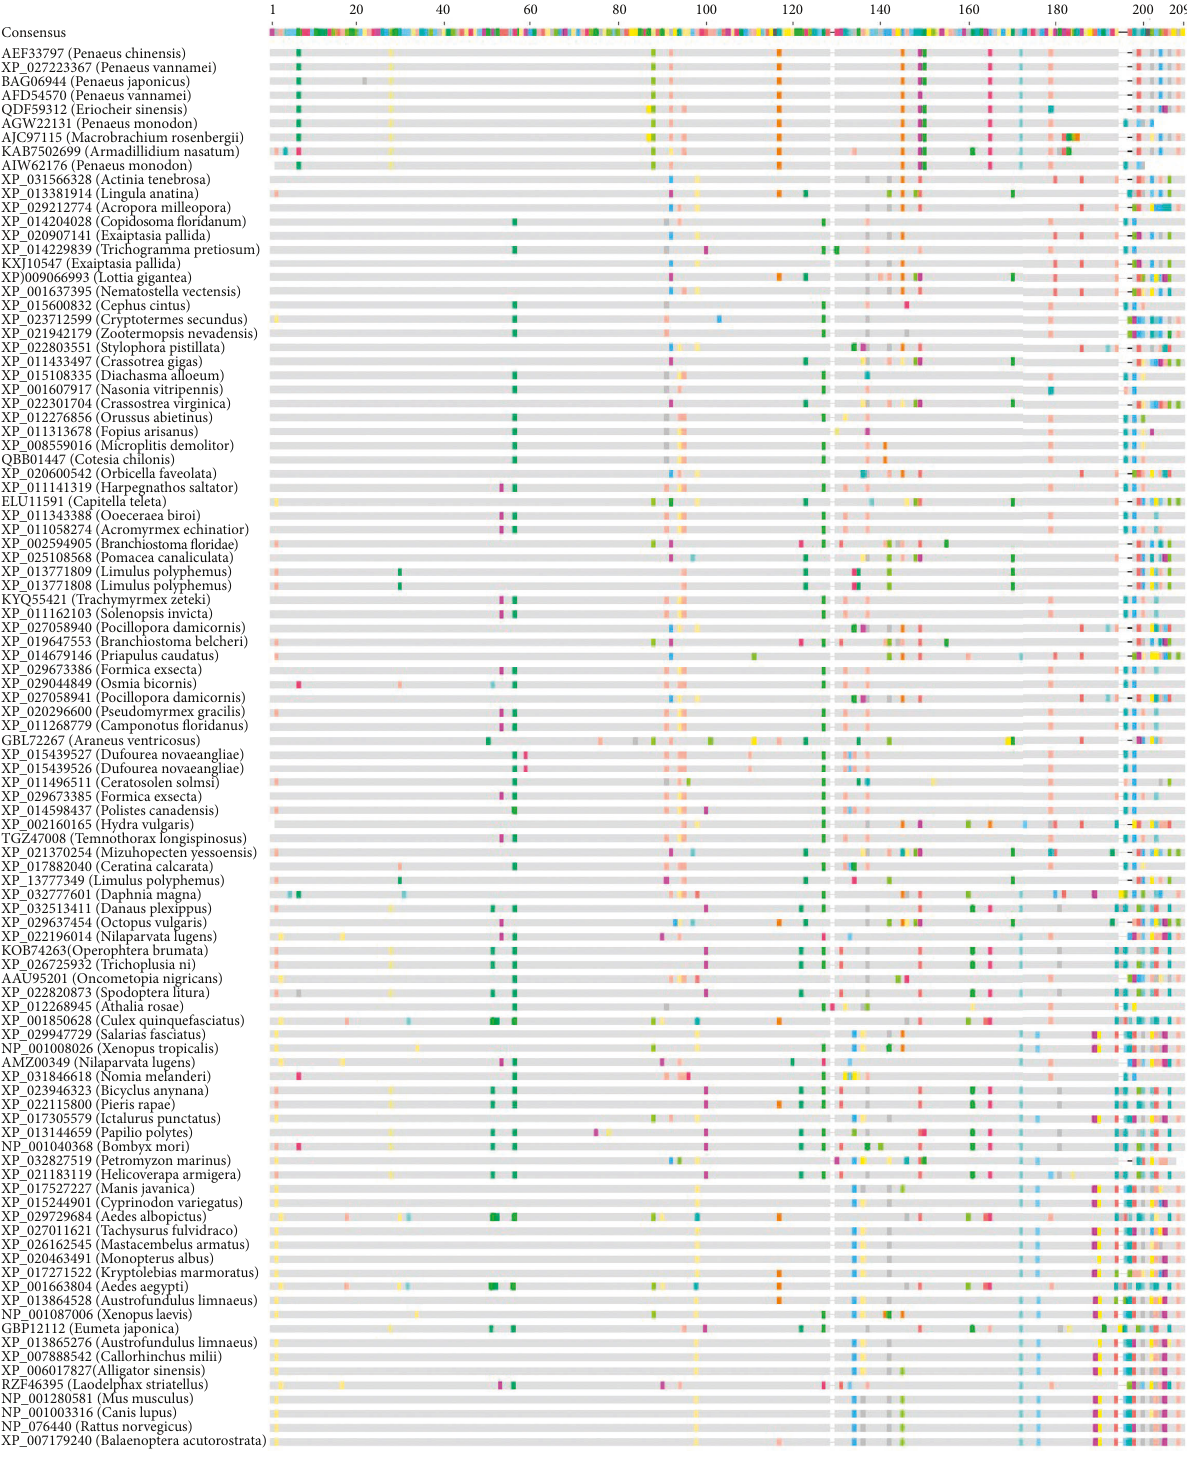
Figure 5: List of accession numbers of sequences with the names of organisms retrieved from NCBI showing disagreements to consensus in the colored blocks generated by geneious version